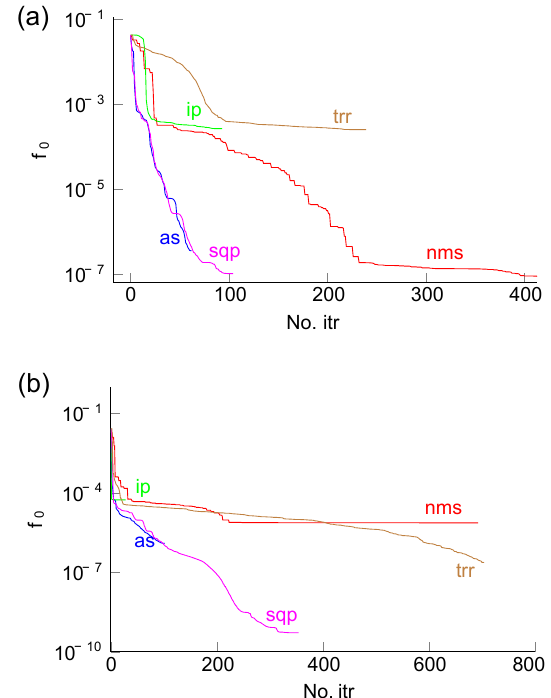
Figure 5. Objective function value vs iteration number for the algorithms Nelder–Mead Simplex (NMS), Trust-Region- Reflective (TRR), Interior-Point (IP), Active-Set (AS) and Sequen- tial Quadratic Programming (SQP). (a) Example1 and (b) Exam- ple